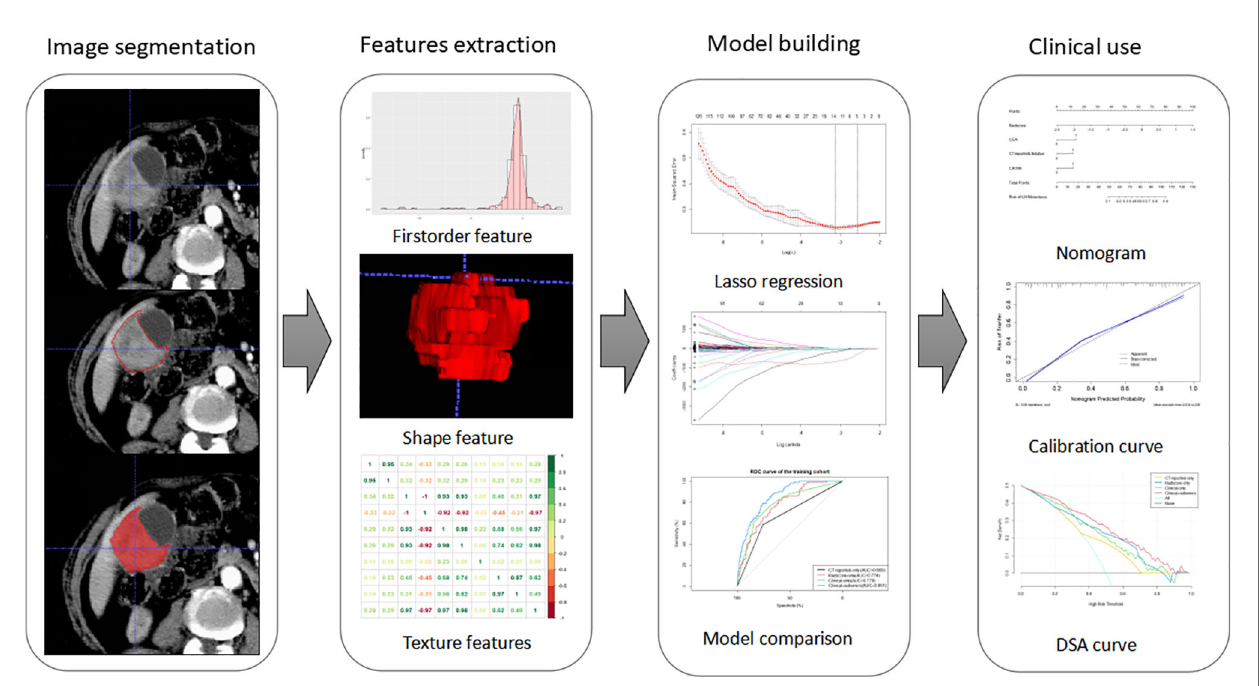
FIGURE 2 | Work fl ow of this study. Tumors are segmented manually on axial portal venous-phase CT section. Radiomics features were extracted from each CT images. LASSO regression was used to select radiomics features. The radiomics signature is constructed by a linear combination of selected features. Then, we built four models and compared their prediction performances with ROC curves. As a result, a clinical-radiomics nomogram was developed based on the best model. Calibration curves and DSA curves were used to evaluate the clinical utility of the